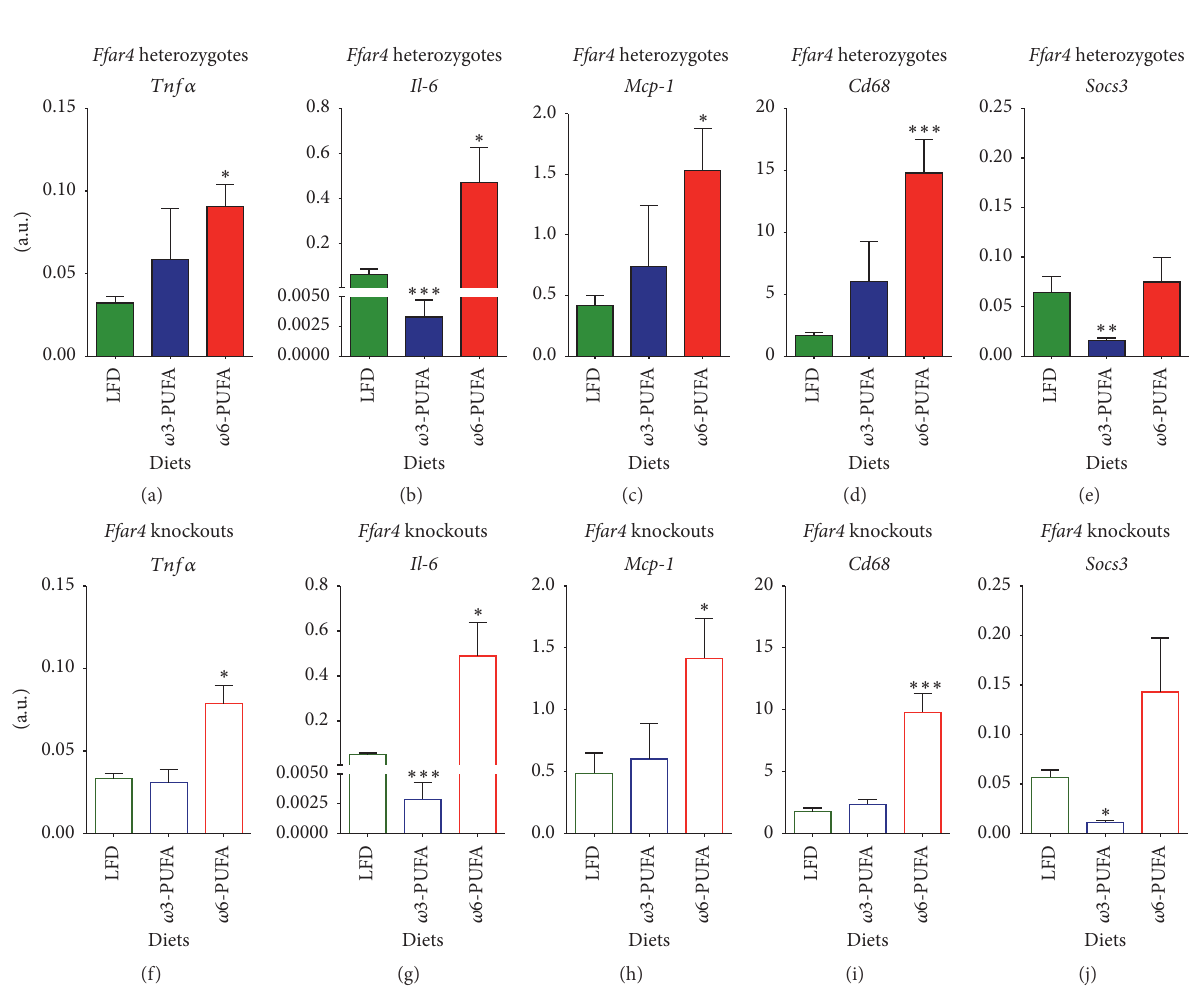
Ffar4 knockouts